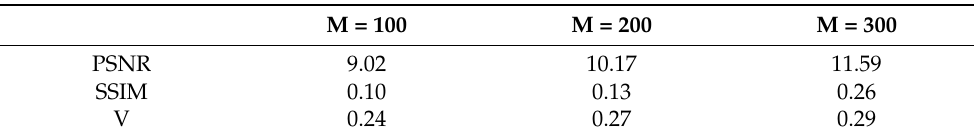
Table 2. The respective peak signal to noise ratio (PSNR) and structural similarity index (SSIM) for different measurements (letter “G”).